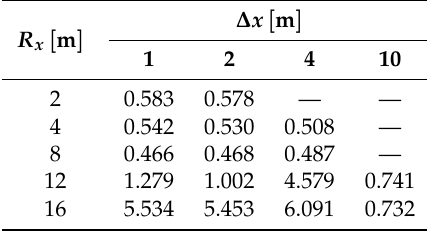
Table 5. Relative RMSE for k , (cid:101) RMS (in %) for h (cid:62) 0.75 m, as a function of ∆ x and R x for ∆ t = 0.5 s k and R t = 1.0 s corresponding to linear propagation of